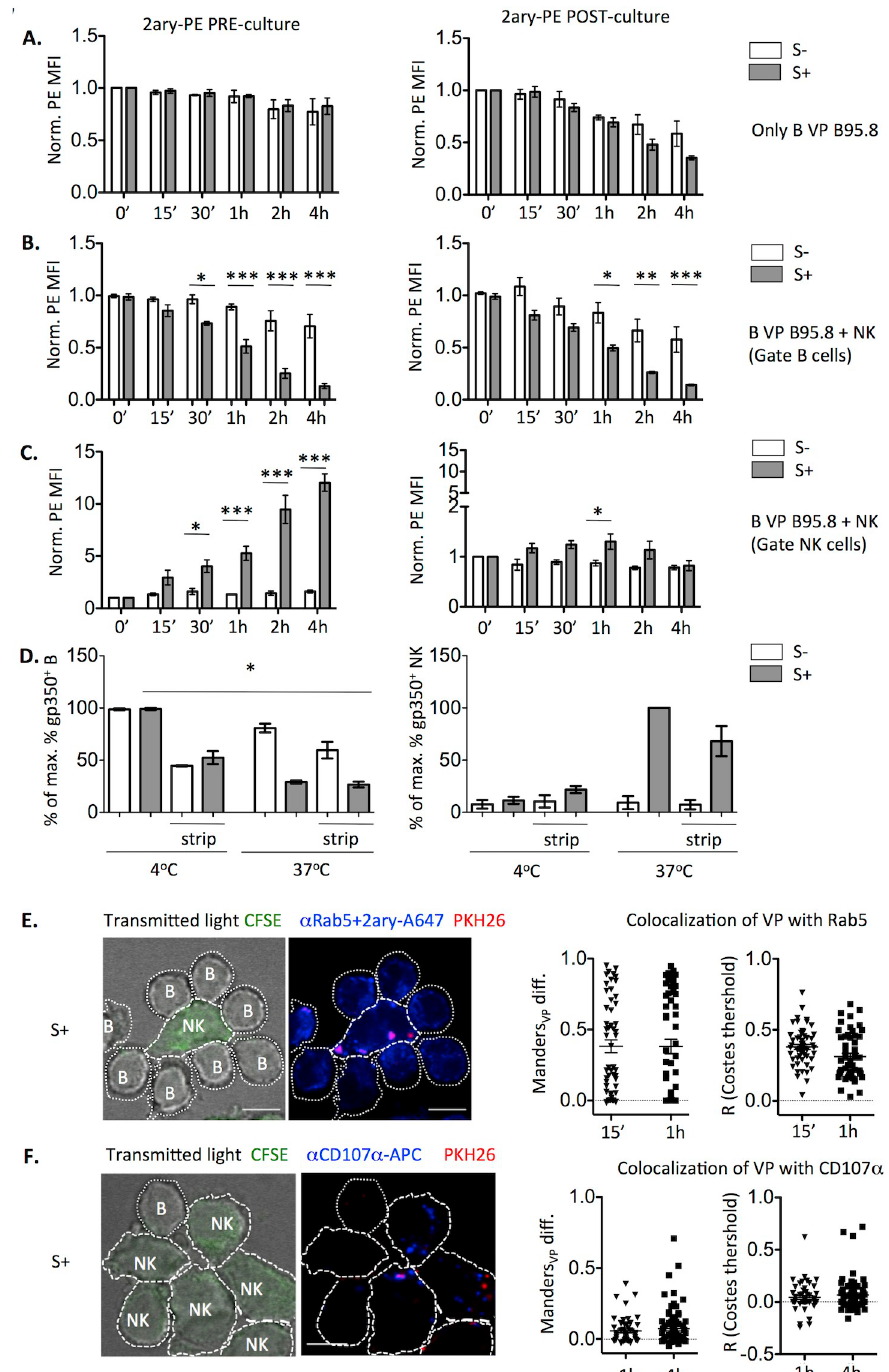
Fig 7. EBV particles are internalized by NK cells and co-localize with endosome and lysosome markers. (A-C) B cells were coated with B95.8 VP and stained by indirect immunofluorescence with anti-gp350 Ab, followed by the PE- conjugated secondary Ab either before (left) or after (right) being incubated alone ( A ) or with NK cells ( B, C ) in the presence of EBV S- or S+ for the indicated times. PE MFI was normalized to that detected on B cells alone ( A , B ) or NK cells ( C ) at time 0; data corresponding to three experiments is shown. Statistical analysis was performed with repeated measures mixed model ANOVA with Bonferroni post-test. ( D) B cells were coated with B95.8 VP, stained for gp350, mixed with NK cells in the presence of EBV S- or S+ sera, incubated at 4˚C or at 37˚C for 4h, and treated or not with trypsin for 30 min. After trypsin neutralization, cells were washed and stained for CD19 detection. Since